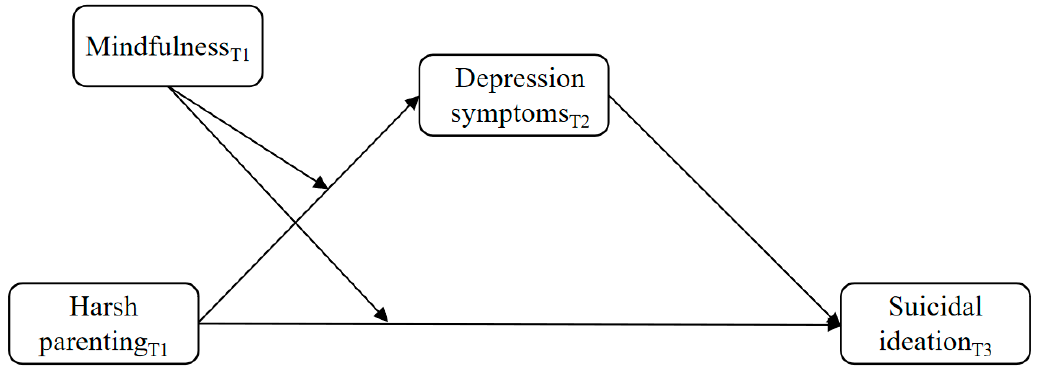
Figure 1. Hypothesis model of the effect of harsh parenting on suicidal ideation through depression symptoms and the moderating effect of mindfulness.